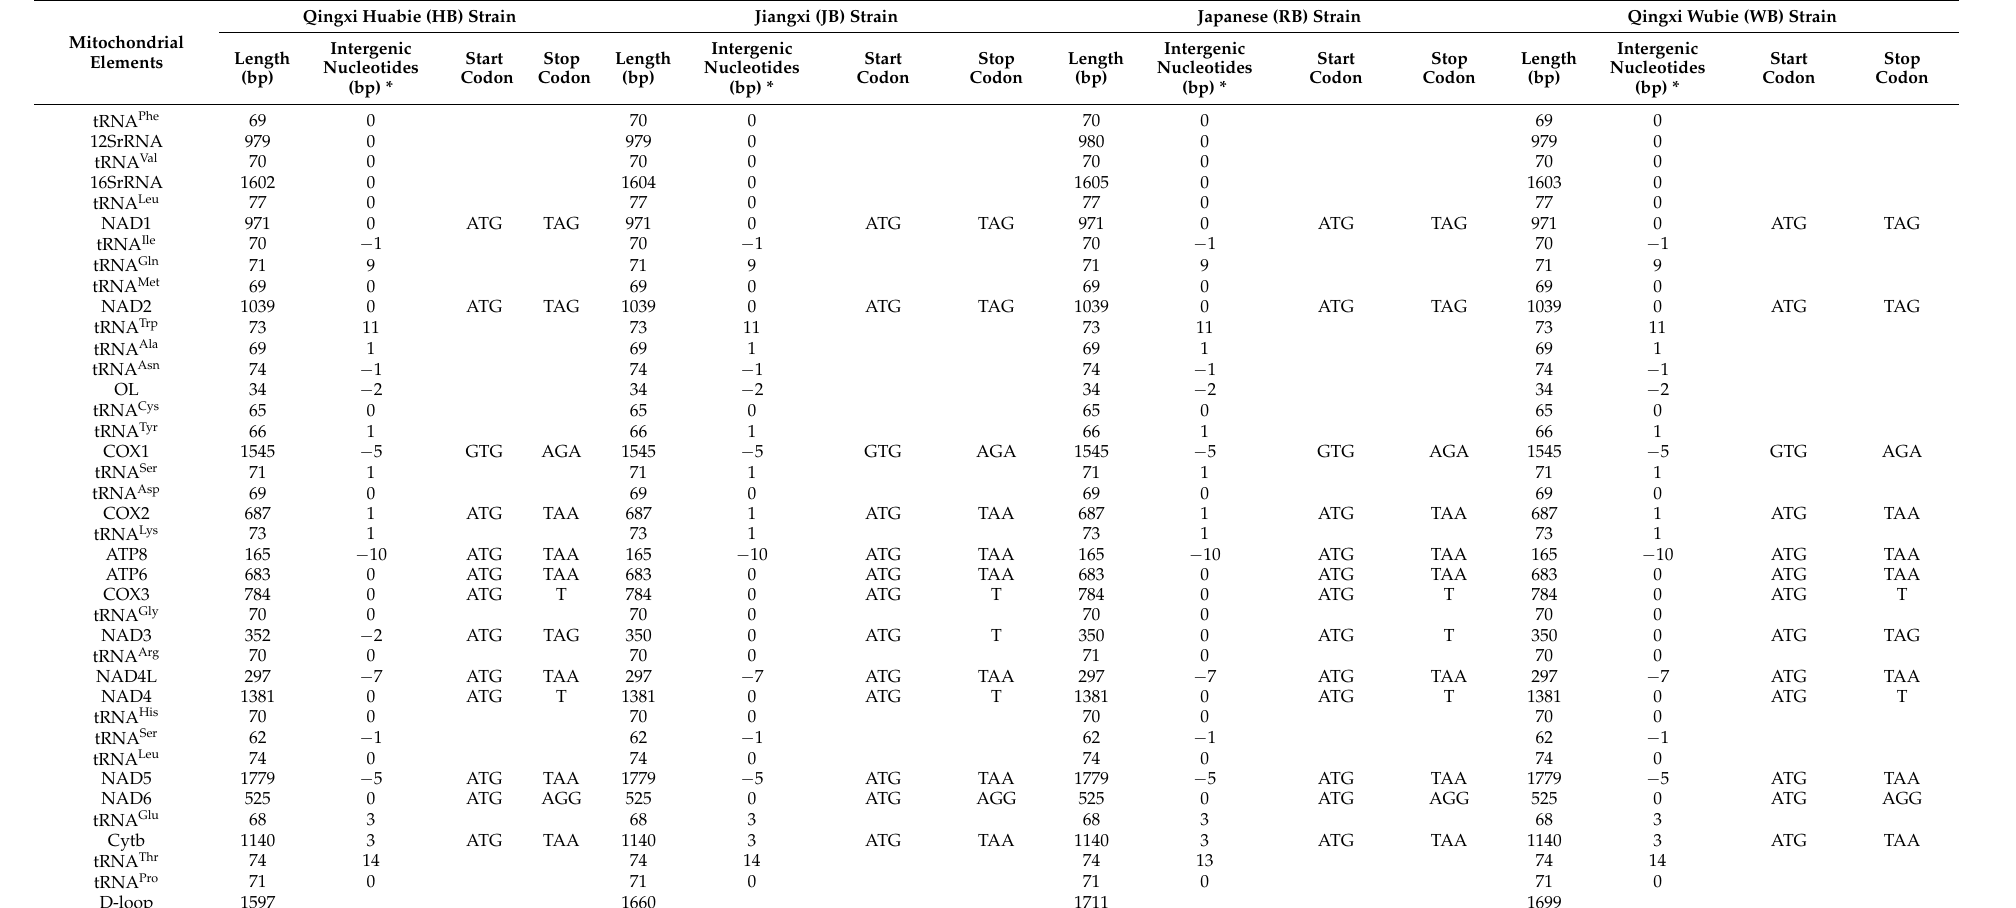
Table 2. Gene length, start codon, and stop codon usage of mitochondrial genomes of four P. sinensis